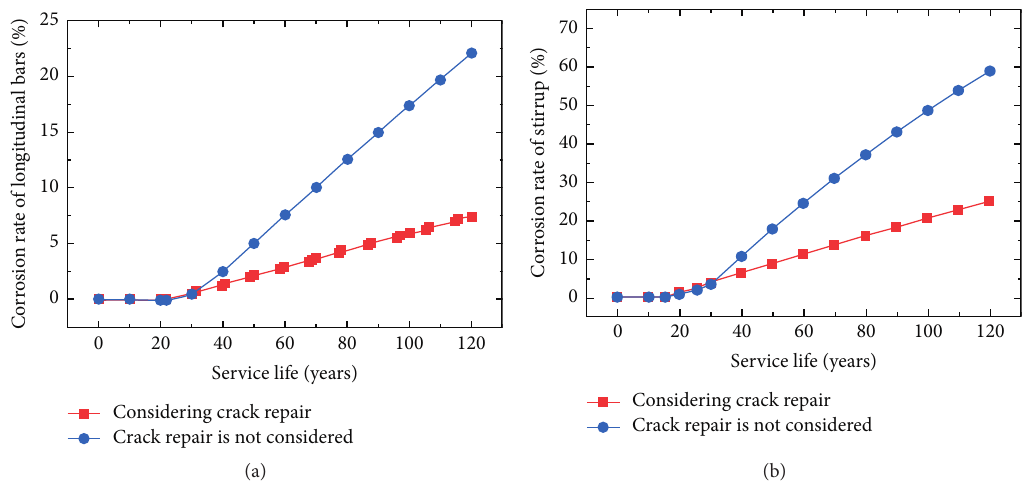
Figure 8: Corrosion rate of steel bars: (a) corrosion rate of longitudinal bars; (b) corrosion rate of